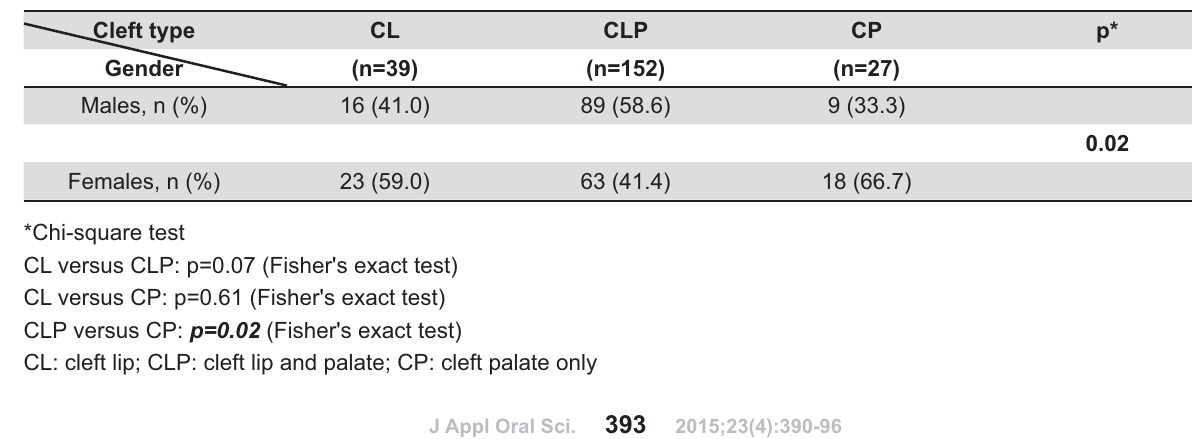
Table 2- Distribution of cleft type according to